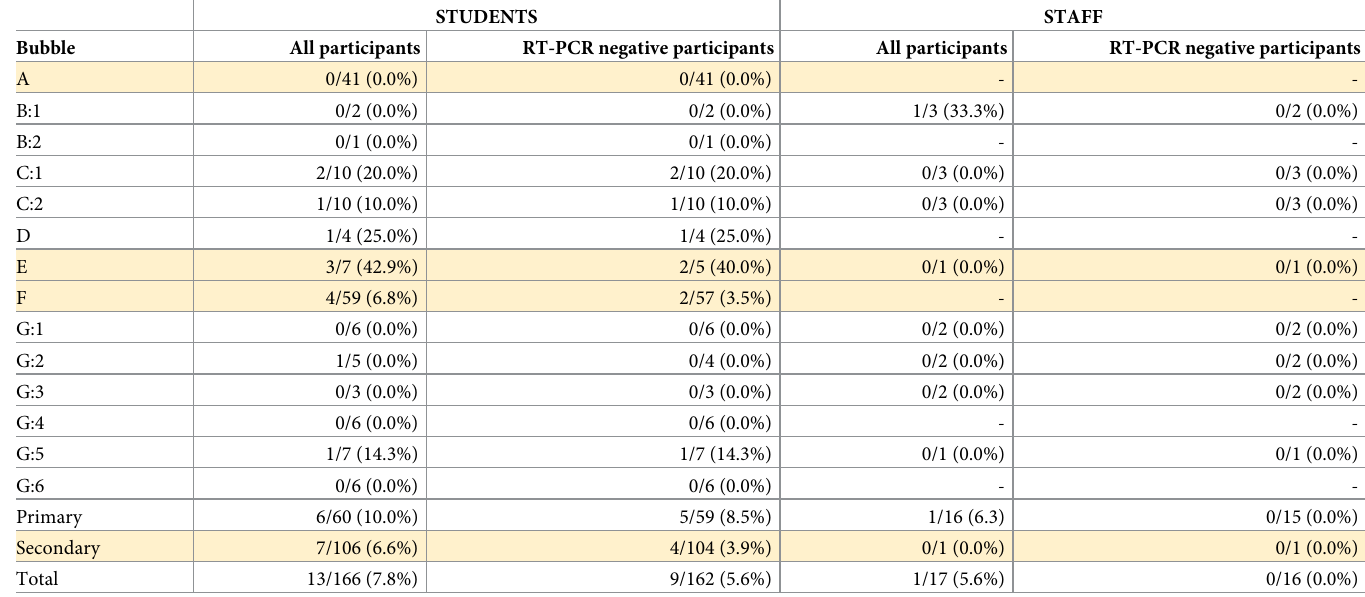
Table 3. Seroconversion rates of students and staff by bubble for all participants returning two oral fluid samples, and in those who were RT-PCR negative. STUDENTS